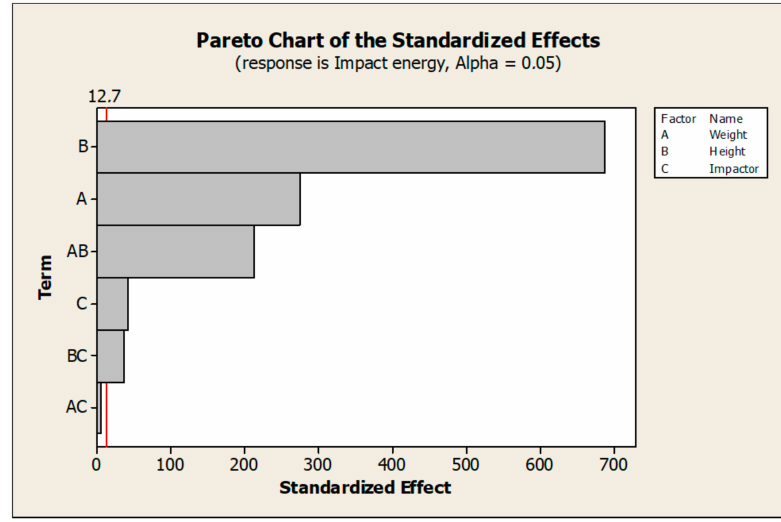
Figure 16. Pareto analysis of significance of factors and